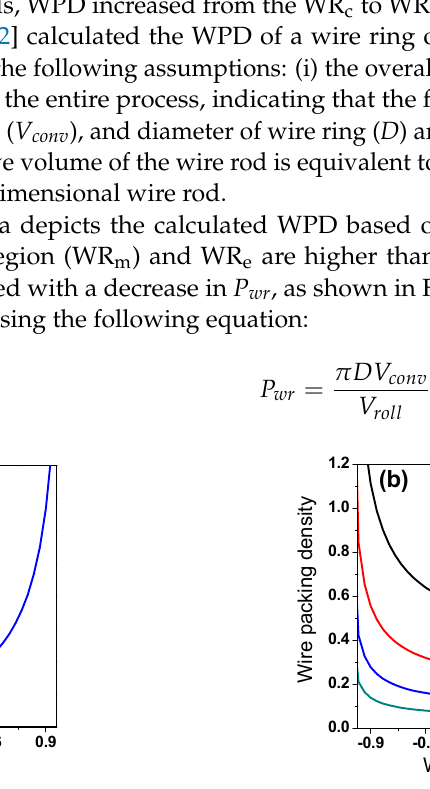
Figure 2. Configuration of wire ring on a Stelmor cooling system and microstructure of wire rod with local decarburization at central region of wire ring.